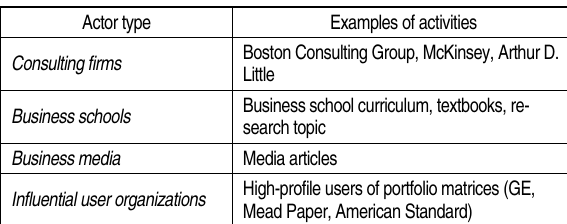
Table 4. The most important actors involved in diffus- ing the BCG